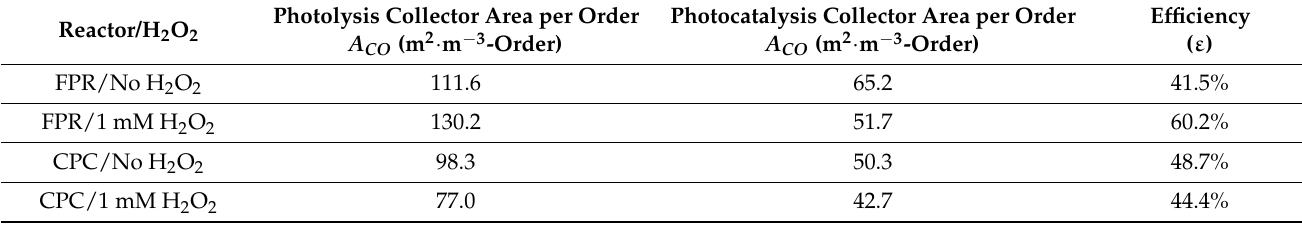
Table 2. Estimation of A CO , (m 2 /m 3 -order) and comparative efficiency for both photolytic and heterogeneous photocatalytic processes, ε = [( A CO degradation, based on a first-order reaction (n = 1), taking place in a batch mode for FPR and CPC